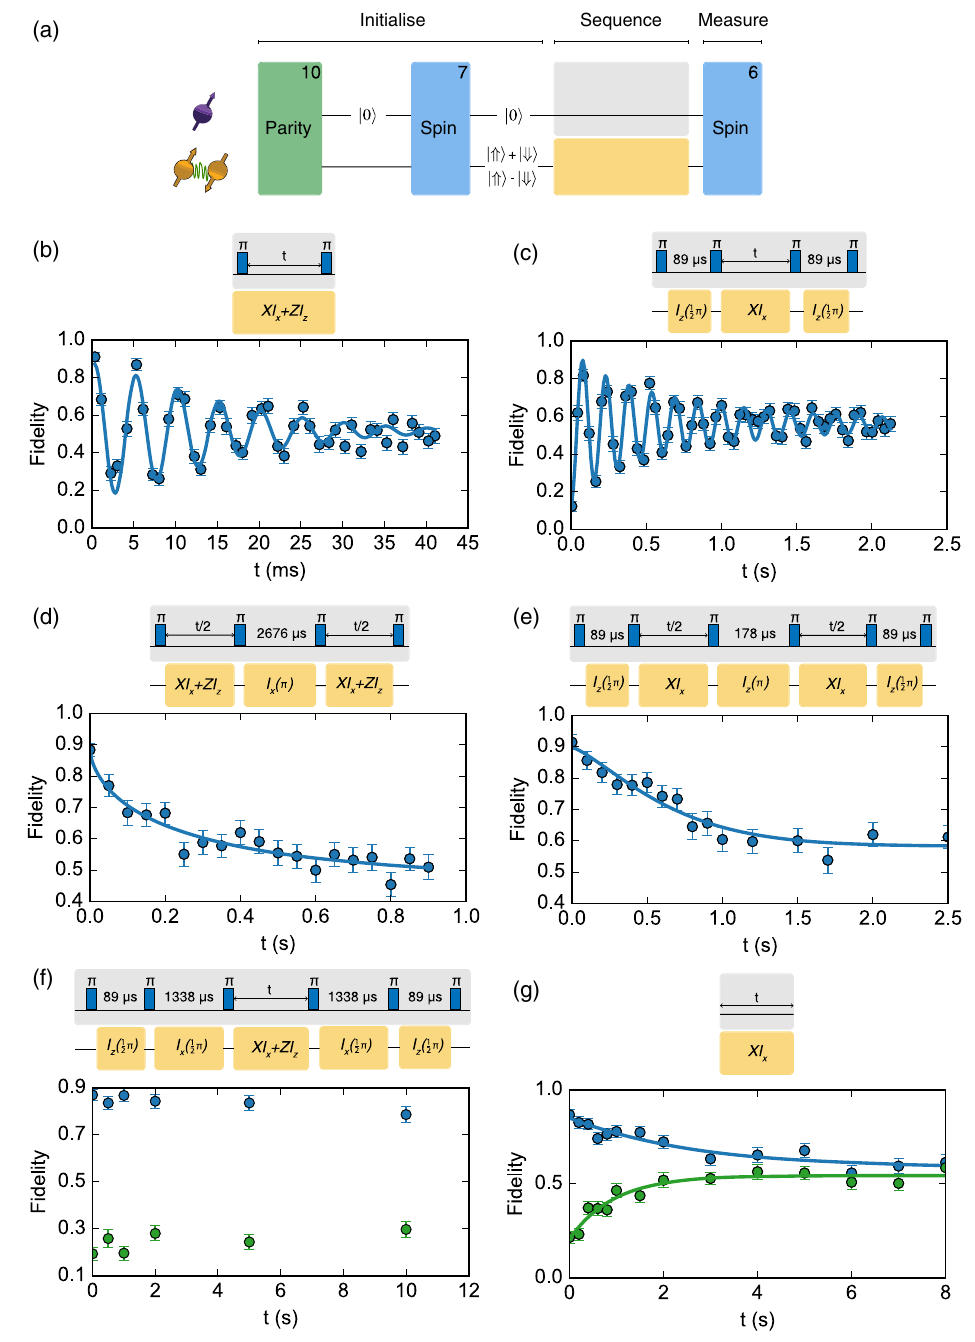
FIG. 7. Coherence and relaxation of pair C . (a) Measurement sequence. First, we use ten parity readouts to herald the pair in the ffiffiffi p 2 antiparallel subspace (condition > 7 = 10 ). Then, we use seven spin readouts to initialize the pair in ð 1 = Þðj ⇑ i þ j ⇓ iÞ ( > 4 = 7 , blue ffiffiffi p 2 data) or ð 1 = Þðj ⇑ i − j ⇓ iÞ ( < 3 = 7 , green data). The various evolution sequences are given as insets in (b) – (g). Finally, six spin readouts are used to read out the spin state. (b) and (c) are fitted to F ð t Þ ¼ a þ Ae − ð t=T Þ n cos ð 2 π ft þ ϕ Þ and (d), (e), and (g) to F ð t Þ ¼ a þ Ae − ð t=T Þ n . (b) Ramsey measurement in m − 1 . T (cid:1) 0 . 018 ð 1 Þ s, n ¼ 1 . 4 ð 2 Þ , and f ¼ 2808 ð 1 Þ Hz (measured with a 200- s ¼ 2 ¼ Hz detuning with respect to 2807 Hz). (c) Ramsey measurement in m s ¼ 0 . T (cid:1) 2 ¼ 0 . 6 ð 1 Þ s, n ¼ 0 . 7 ð 1 Þ , and f ¼ 188 . 33 ð 2 Þ Hz (measured with a 5-Hz detuning with respect to 186.8 Hz). (d) Spin echo measurement in m s ¼ − 1 . T 2 ¼ 0 . 3 ð 2 Þ s and n ¼ 0 . 6 ð 2 Þ . (e) Spin echo measurement in m s ¼ 0 . T 2 ¼ 0 . 7 ð 1 Þ s and n ¼ 1 . 3 ð 3 Þ . (f) Relaxation measurement in m s ¼ − 1 . T 1 ≫ 1 s. (g) Relaxation ffiffiffi p 2 measurement in m s ¼ 0 . T 1 ¼ 3 . 6 ð 7 Þ s and n ¼ 0 . 8 ð 2 Þ for the blue data [ ð 1 = Þðj ⇑ i þ j ⇓ iÞ ]. T 1 ¼ 0 . 9 ð 2 Þ s and n ¼ 1 . 0 ð 2 Þ for the ffiffiffi p 2 green data [ ð 1 = Þðj ⇑ i − j ⇓ iÞ ]. The relaxation times are different for the two eigenstates, indicating a mechanism that depends on whether the state is a singlet or